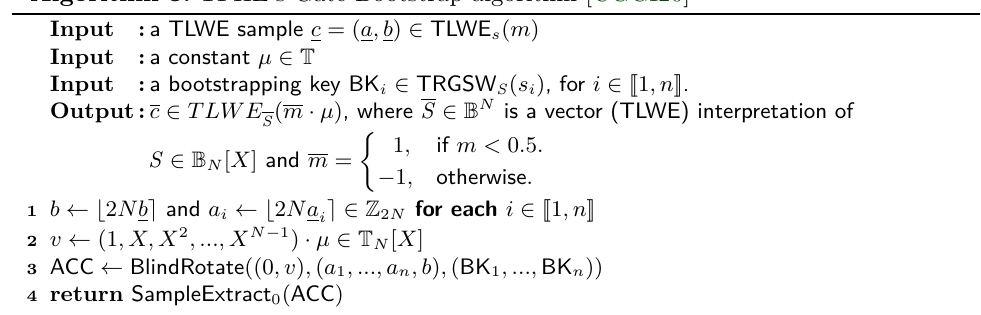
Algorithm 3: TFHE’s Gate Bootstrap algorithm